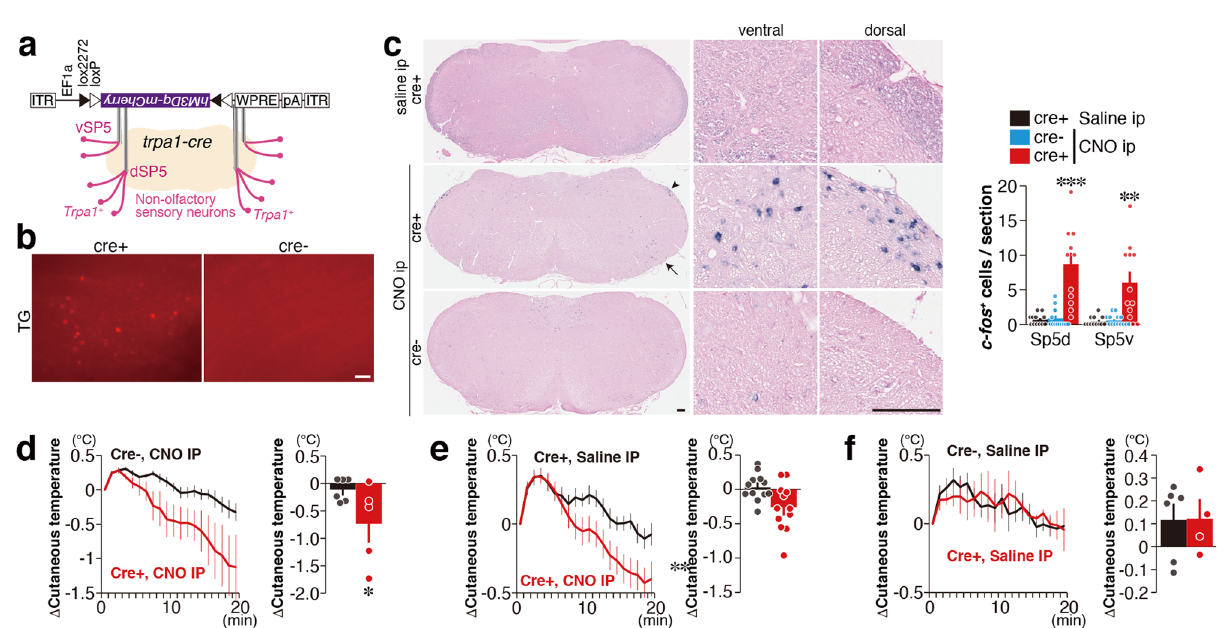
Fig. 5 Hypothermia induced by the Trpa1 + neurons projecting to the Sp5. a , b The experimental design of the chemogenetic activation of Trpa1 + neurons projecting to the Sp5 ( a ) and representative retrograde-labeled mCherry expression in the TG in Trpa1-Cre and control mice ( b ). c Representative images of medulla (left), magni fi ed views in the ventral and dorsal parts of Sp5 (middle; areas indicated by arrow and arrowhead in the left fi gure), and quanti fi cation (right) of c-fos + cells in the dorsal Sp5 (Sp5d) and ventral Sp5 (Sp5v) after clozapine-N-oxide (CNO) administration (Sp5d, n = 12 for Trpa1-Cre + /sal, n = 14 for Trpa1-Cre − /CNO, and n = 24 for Trpa1-Cre + /CNO, p = 0.9850 between Trpa1-Cre + /saline and Trp1-Cre − /CNO, and p < 0.0001 between Trpa1-Cre + /saline and Trpa1-Cre + /CNO; Sp5v, n = 12 for Trpa1-Cre + /sal, n = 13 for Trpa1-Cre − /CNO, and n = 24 for Trpa1-Cre + /CNO, p = 0.9947 between Trpa1-Cre + /sal and Trpa1-Cre − /CNO, and p = 0.0043 between Trpa1-Cre + /saline and Trpa1-Cre + /CNO) are shown. d Temporal and mean cutaneous temperature after CNO administration are shown for hM3Dq-infected Trpa1-Cre (red) and control (black) mice ( n = 6 for control and n = 5 for Trpa1-Cre , p = 0.0179). e Temporal and mean cutaneous temperature after administration of saline (black) and CNO (red) are shown for hM3Dq-infected Trpa1-Cre mice ( n = 12 each, p = 0.0018). f Temporal and mean cutaneous temperature after administration of saline are shown for Trpa1-Cre (red) and control (black) mice ( n = 6 for control and n = 4 for Trpa1-Cre , p = 0.500). Data are shown as mean ± SEM. One-way ANOVA followed by Dunnett ’ s multiple comparison test ( c ), unpaired one-tailed Student ’ s t test ( d ), paired one-tailed Student ’ s t test ( e ), and Mann – Whitney U test ( f ) were used to assess signi fi cance; * p < 0.05; ** p < 0.01; *** p < 0.001. Scale bars, 100 µ